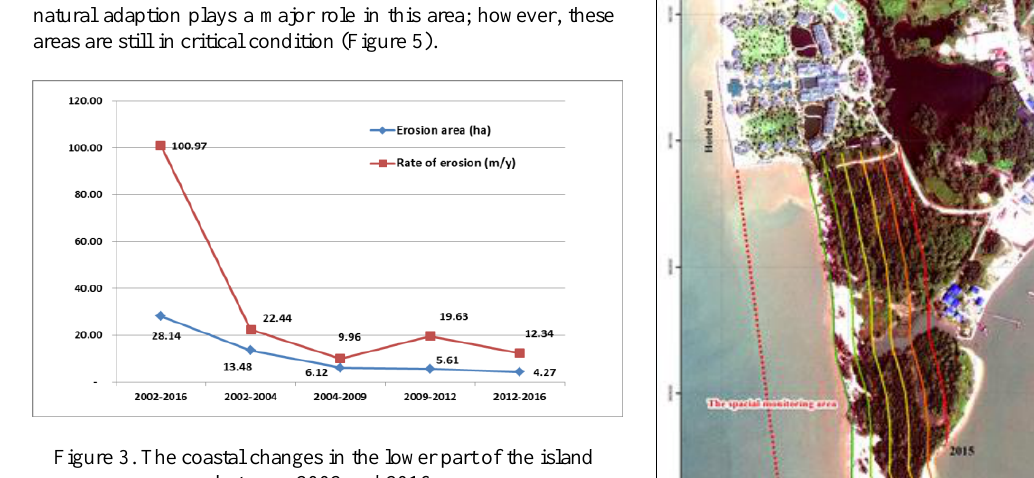
Figure 3. The coastal changes in the lower part of the island between 2002 and 2016